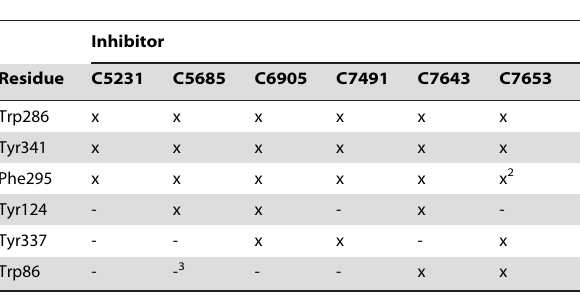
Table 3. Interactions patterns observed in the determined complexes between the ligands and the corresponding residues in m AChE.